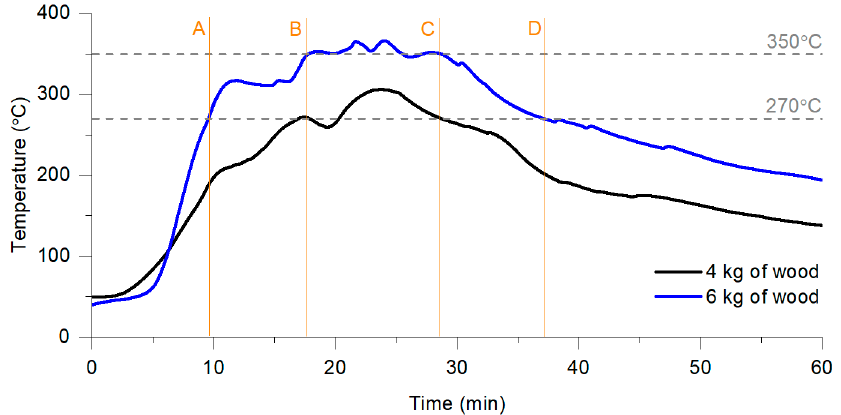
Figure 6. Temperature variations on the stove’s rear wall during combustion of 4 and 6 kg of wood.